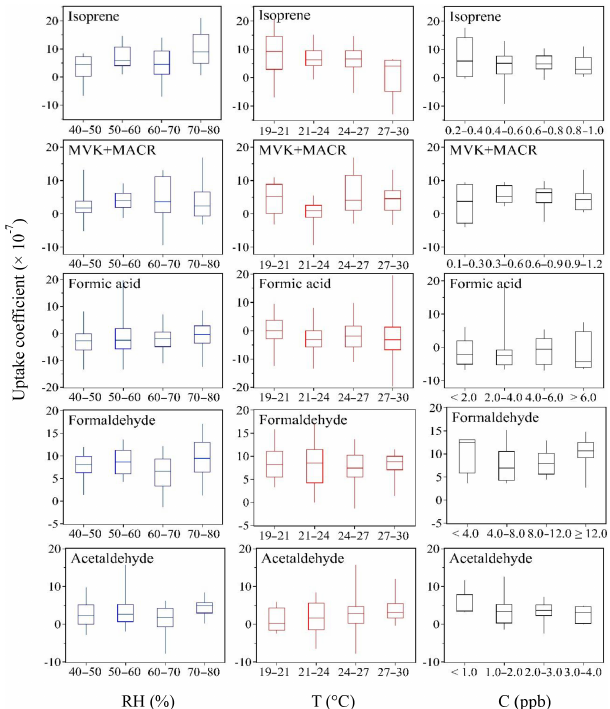
Figure 8. Dependence of uptake coefficients on ambient relative humidity (RH), temperature ( T ) and mixing ratios ( C ). The 25th, 50th and 75th percentiles and minimum and maximum of the box- and-whisker plots are indicated by bars. The uptake coefficient de- pendence is based on the hourly averaged data, and the RH and T dependences are plotted when C is varied within a very nar- row range (nearly constant) and C dependence is plotted when RH equals 50%. Note that negative uptake coefficients indicate emis- sion. For details see